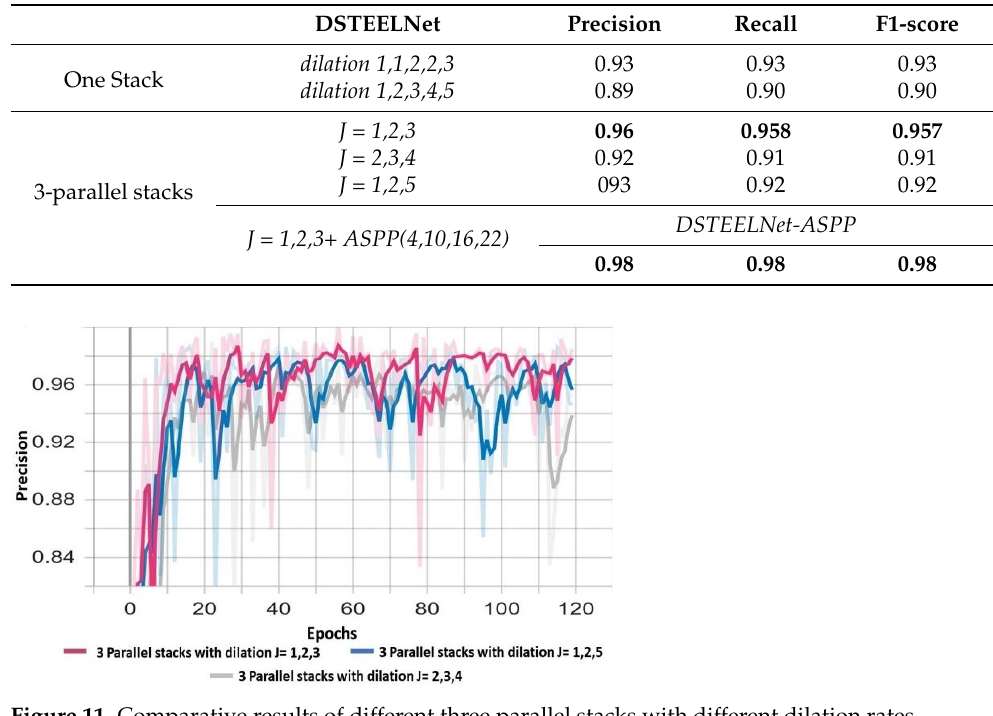
Figure 11. Comparative results of different three parallel stacks with different dilation rates.